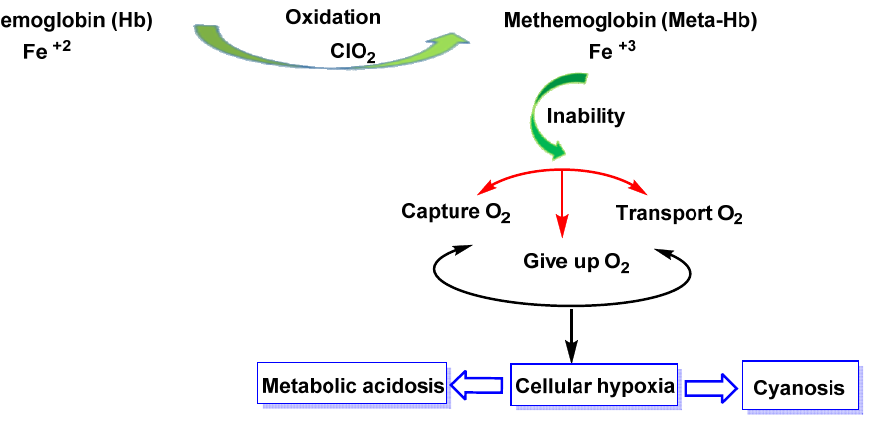
Figure 43. Methemoglobinemia